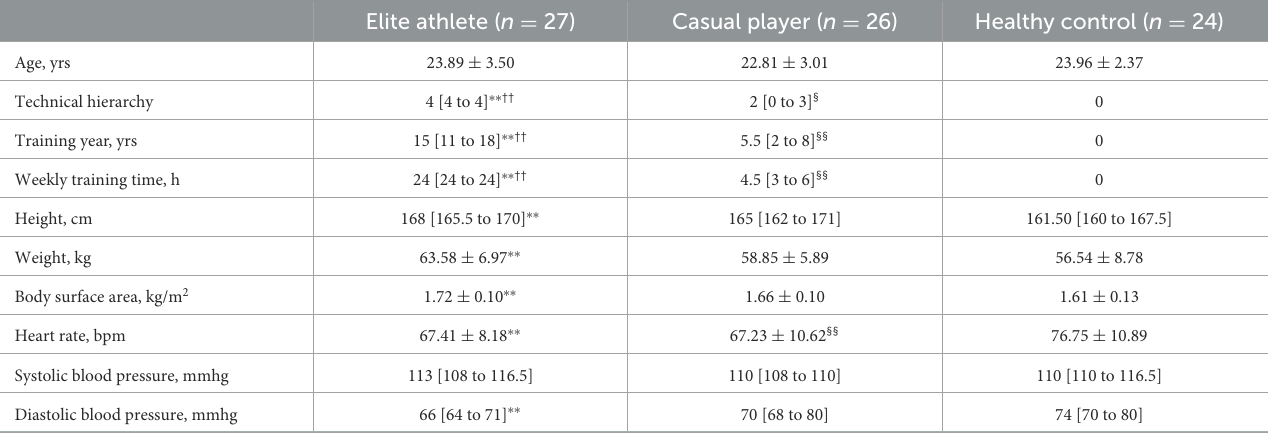
TABLE 1 Basic information of